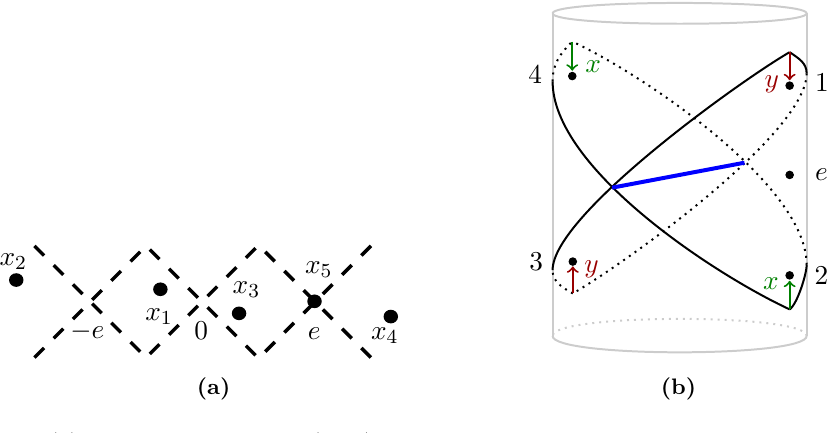
. It simplifies Figure 7. (a) Symmetrical frame (3.23) with − x 1 = x 3 = y , − x 2 = x 4 = x − x 2 subleading terms in the Regge limit compared with figure 6. (b) The same coordinates on the cylinder, with x, y → 0 interpreted as displacements away from the Regge limit (compare with [48]). In holographic theories, injecting a large momentum ν into x, y effectively flows a large transverse momentum through the bulk AdS shown as a thick blue line. This is key to probing small-impact d − 1 parameter scattering. (The shown coordinates are on a different Poincaré patch compared with (a); the double commutator in the right kinematics is proportional to block computed on the